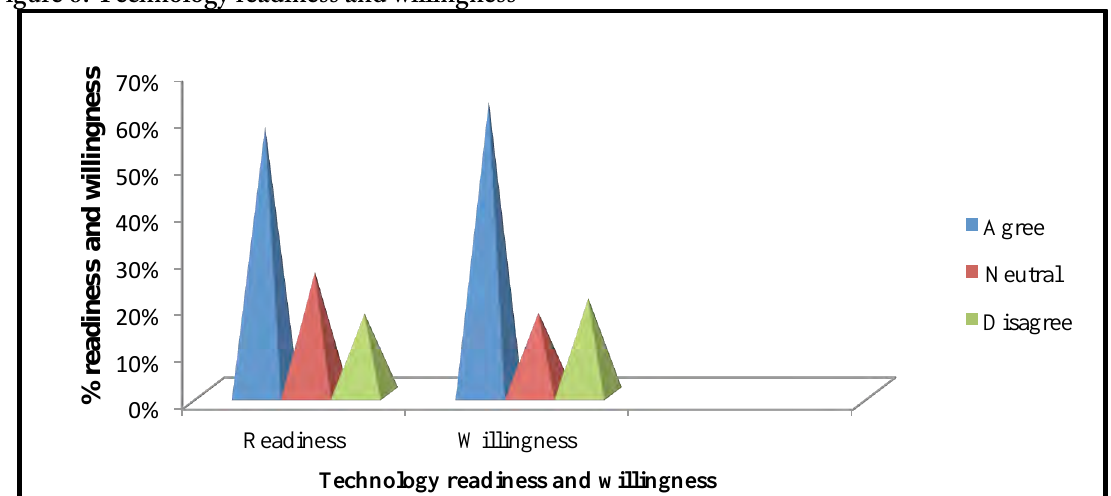
Figure 6: Technology readiness and